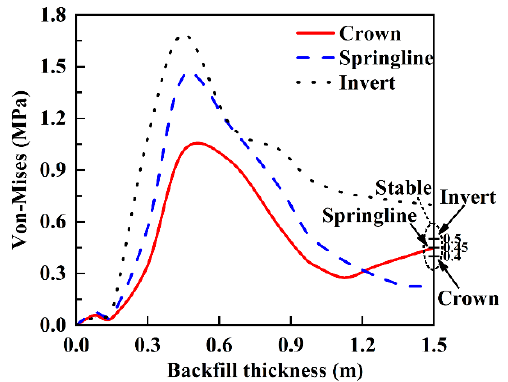
Figure 8. The Von-Mises stress of the pipe during the installation.